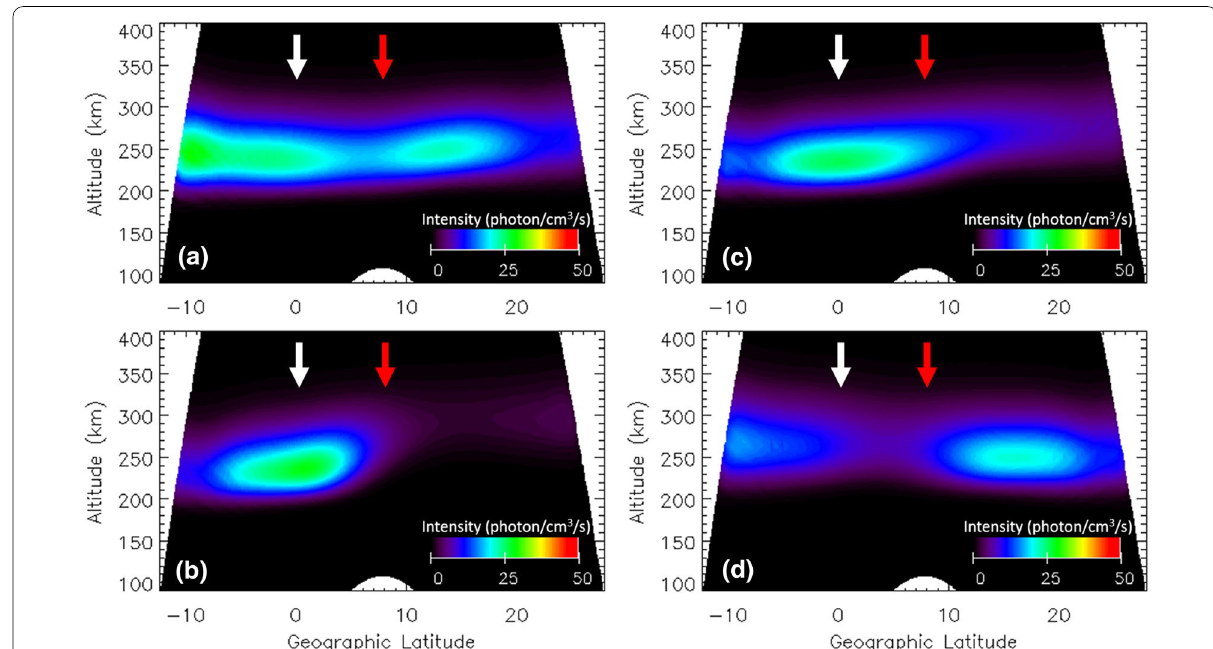
Fig. 4 Simulation results of the 630.0 nm nightglow based on the SAMI‑2 model, plotted in the latitude‑altitudinal plane at midnight on a March 1, 2007, b June 1, 2007, c September 1, 2007, and d December 1, 2007 along the 50°E longitude. The white arrows indicate the geographic equator, and the red arrows indicate the geomagnetic